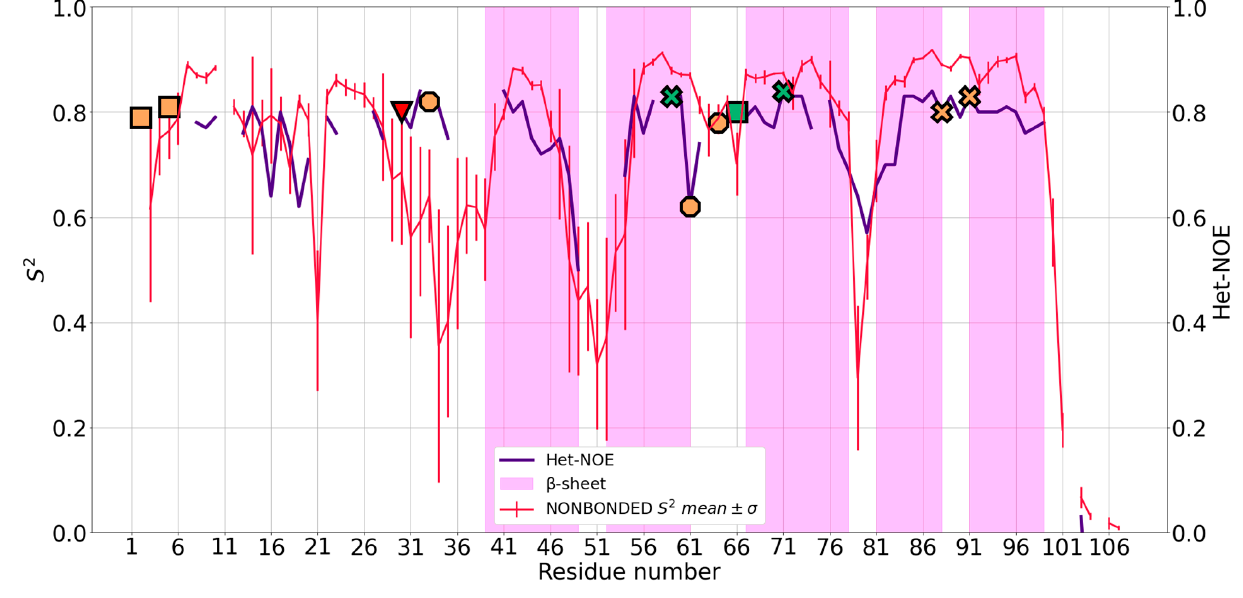
Figure 4. Mean S 2 of 2JOX and standard deviation (SD) for nonbonded (red) simulations superim- posed to Het-NOE data (purple). It was not possible to apply ZAFF to the system. The y-axis was truncated at 0 because S 2 had no negative values, hence some Het-NOE data for the last protein residues were not visible. Orange markers represent the position in the sequence of zinc(II)-binding Cys residues, whereas the green markers represent zinc(II)-binding His residues. Residues belonging to the same site are represented with the same marker shape (crosses for the mononuclear site; circles for the binuclear site except the bridging Cys 30 , which is represented as a red triangle).